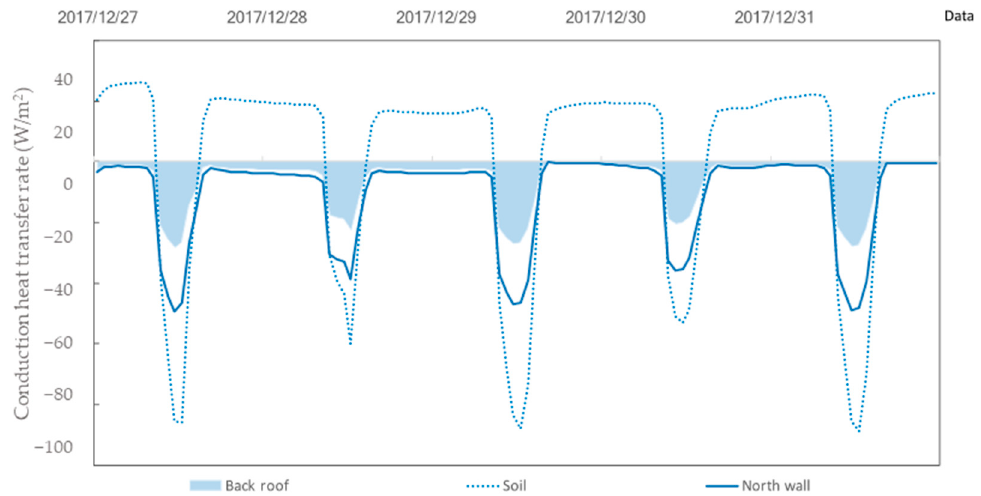
Figure 21. Conduction heat transfer on the inside surfaces of the CSG on cloudy days.